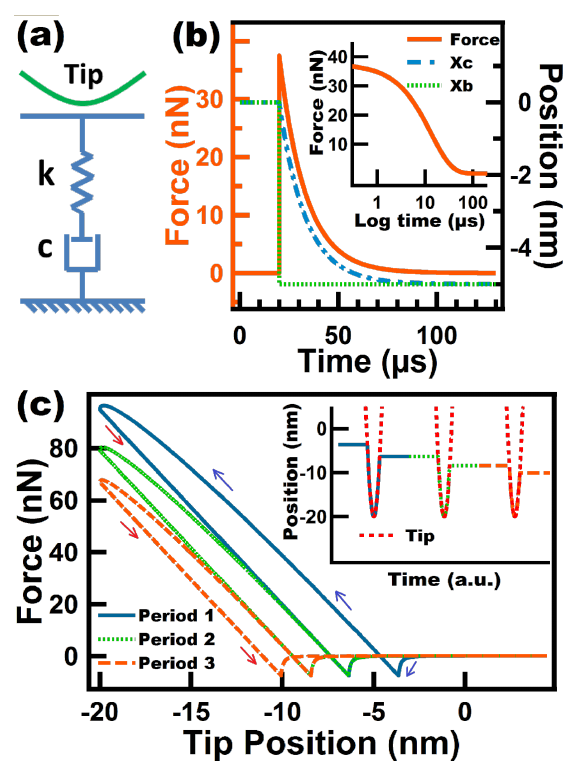
Figure 1: (a) Linear Maxwell model schematic; (b) stress relaxation simulation performed on a Linear Maxwell surface. The surface pos- ition ( X b ) is depressed to a constant position of 5 nm below its unper- turbed state, starting at t = 20 µs. The inset shows the same stress relaxation experiment but starting at t = 0 µs, and the horizontal axis is intentionally plotted by using a logarithmic scale to show the inflection point corresponding to its single relaxation time. (c) Force–distance tip trajectories (the trajectory proceeds in the counterclockwise direction) for a prescribed sinusoidal tip trajectory given by z ( t ) = 80 nm + (100 nm) sin( ω t ), where ω is 2 π times 25 kHz. The inset shows three consecutive tip–sample taps, each one separated by a fundamental period equal to 1/25 ms. The Linear Maxwell parameters used were k = 7.5 N/m and c = 1.0 × 10 − 4 N·s/m. The blue and red arrows in (c) correspond to approach and retraction of the tip,